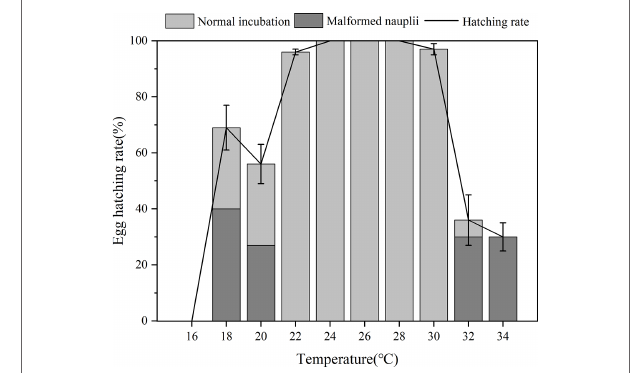
FIGURE 4 | Egg hatching rate of B. amoyensis incubated at three different light intensities (N=45). Data are presented as mean ± standard error (SE).